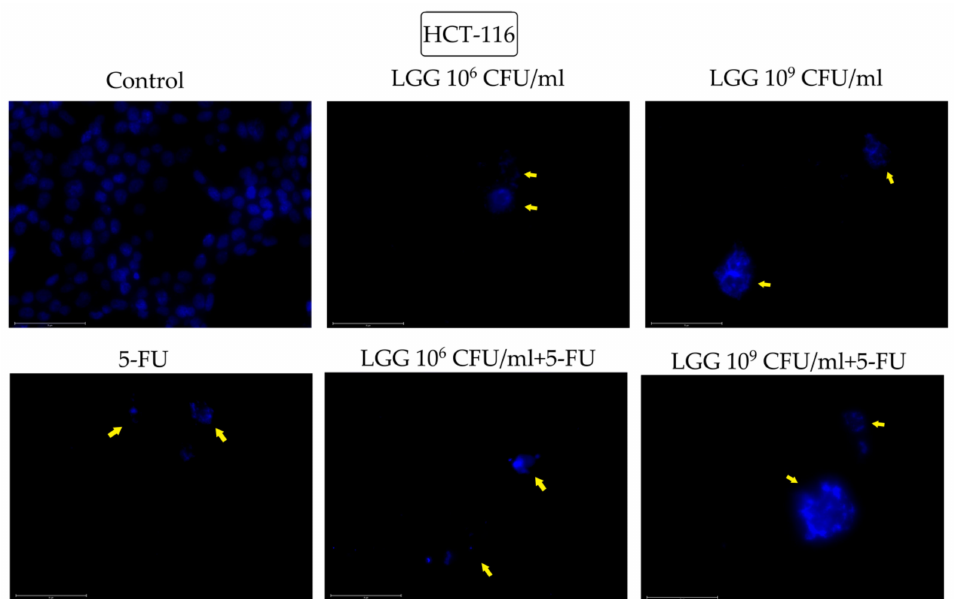
Figure 4. Nuclear morphological changes in HCT-116 cells observed following 48 h treatment with LGG 10 6 and 10 9 CFU/mL, alone or in association with 10 µ M 5-FU. The yellow arrows represent signs of apoptosis (nuclear shrinkage, fragmentation, condensation, and cellular membrane disruption). The scale bar is 75 µ